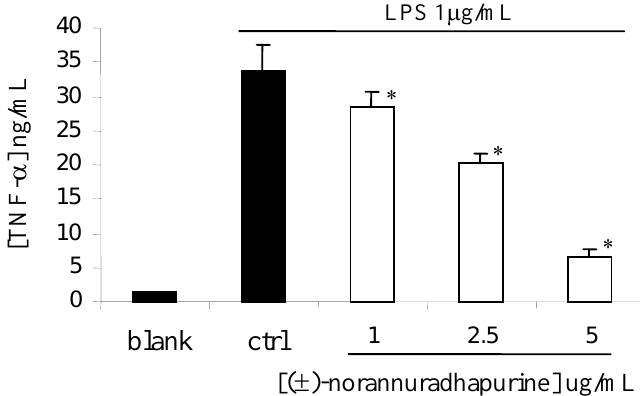
Figure 5 . Effect of (±)-±)-norannuradhapurine on LPS-induced TNF- α production by RAW 264.7 cells. The values are the means of at least three determinations ±